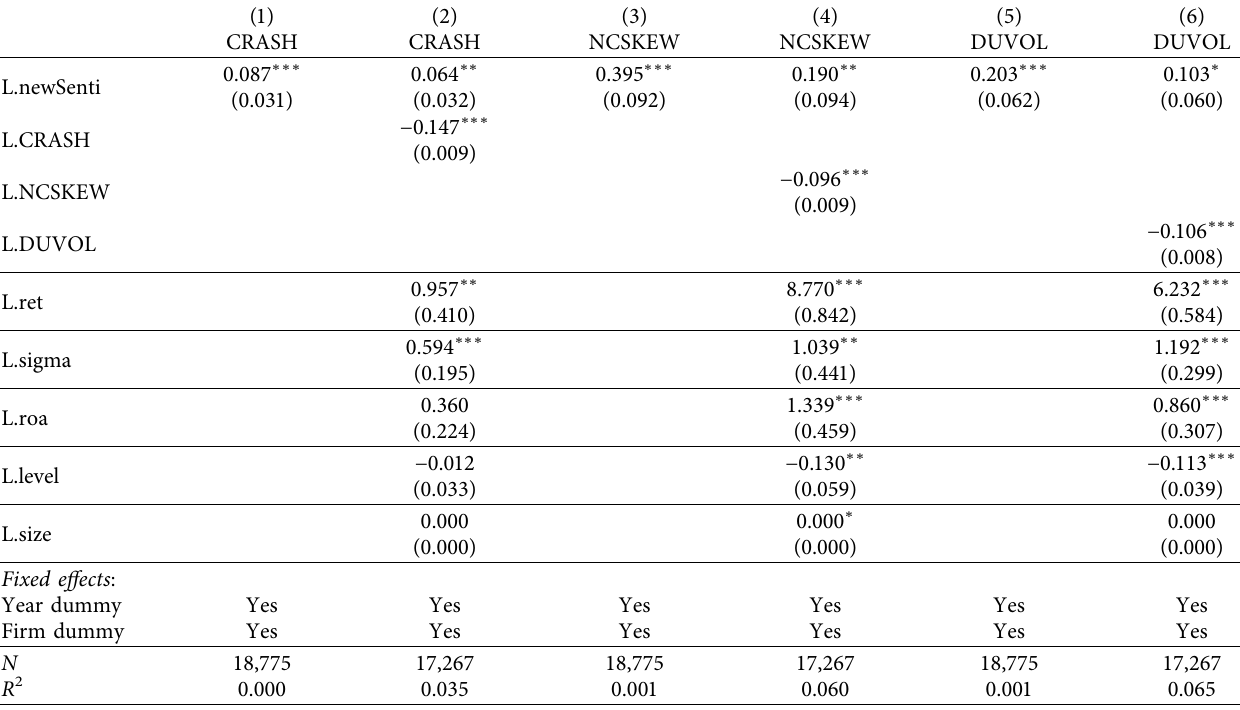
Table 4: Baseline